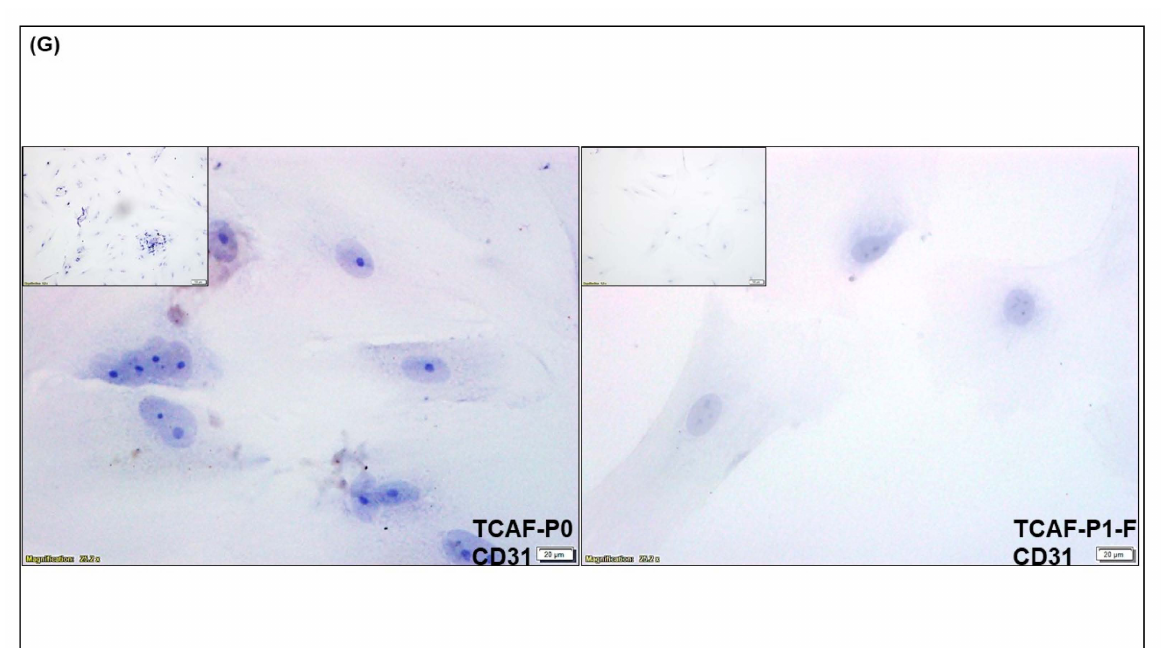
Figure 5. Cellular localization of proteins for CAF markers in the Patient-Derived primary culture of ovarian CAF from pre- and post-frozen passages established from the representative tumor sample, HU-A148-Ov2 of ovarian cancers: We tested the cellular localization of the expression of protein by ICC for SMA ( B ), TE-7 ( C ), PD-L1 ( D ), S100A4 ( E ), CK 8, 18 ( F ), and CD31 ( G ) in Patient- Derived CAFs (before and after thawing). The morphological features are presented by H&E stain ( A ). Insets represent photomicrographs in lower